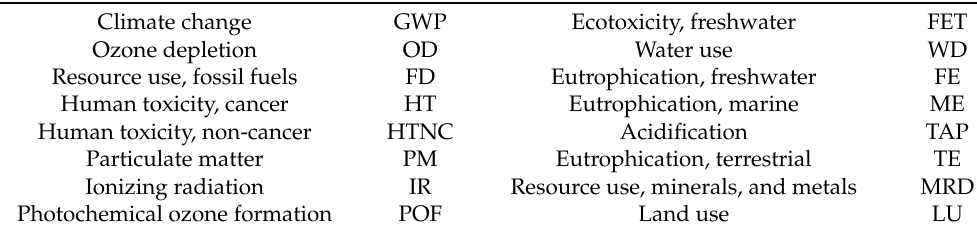
Table 1. Midpoint impacts and their abbreviations used in this